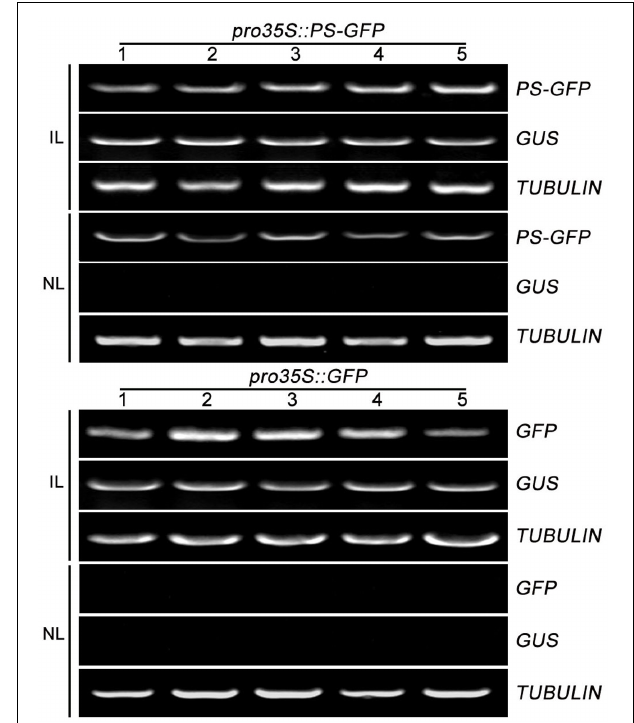
FIGURE 3 | The mobility of PS-GFP mRNA in tomato. RT-PCR analysis of mRNA levels of PS-GFP and GFP in infiltrated and non-infiltrated leaves of tomato. Expression of TUBULIN and GUS served as controls. IL, infiltrated leaves; NL, non-infiltrated